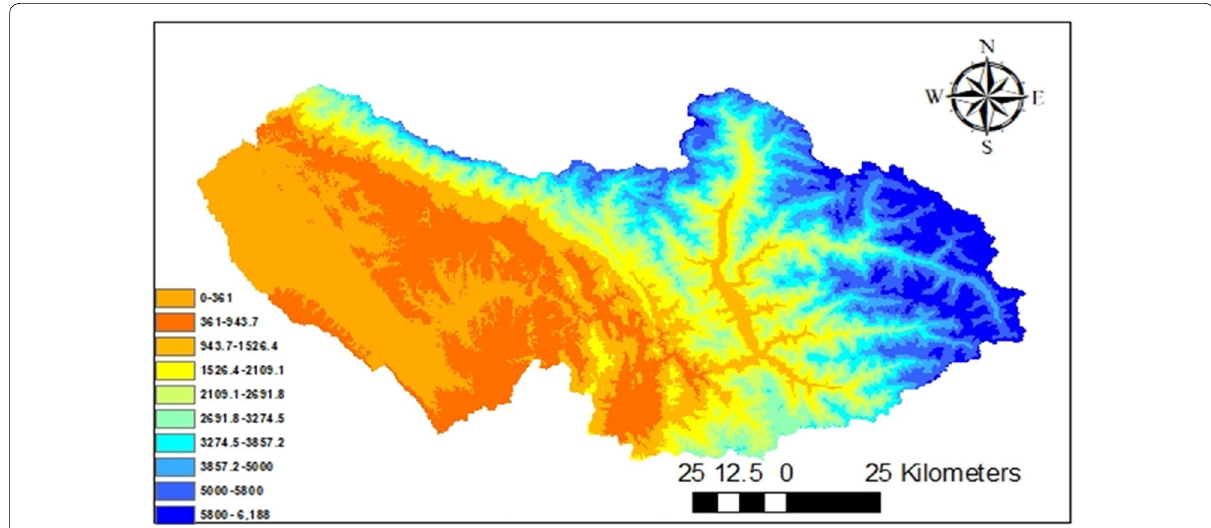
Fig.5 Elevation zone map of the